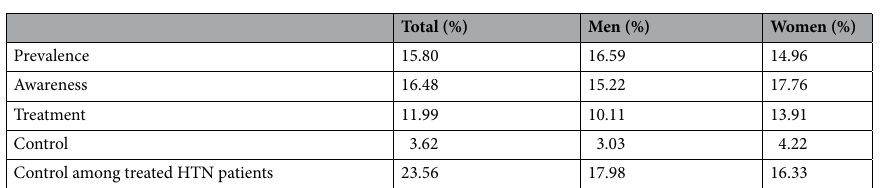
Table 3. Age and sex-standardized prevalence, awareness, treatment, control of HTN for the study group, and age-standardized rates for men and women. Data are presented as n%; the standardized procedure was according to the data of the 2010 Population Census of the People’s Republic of